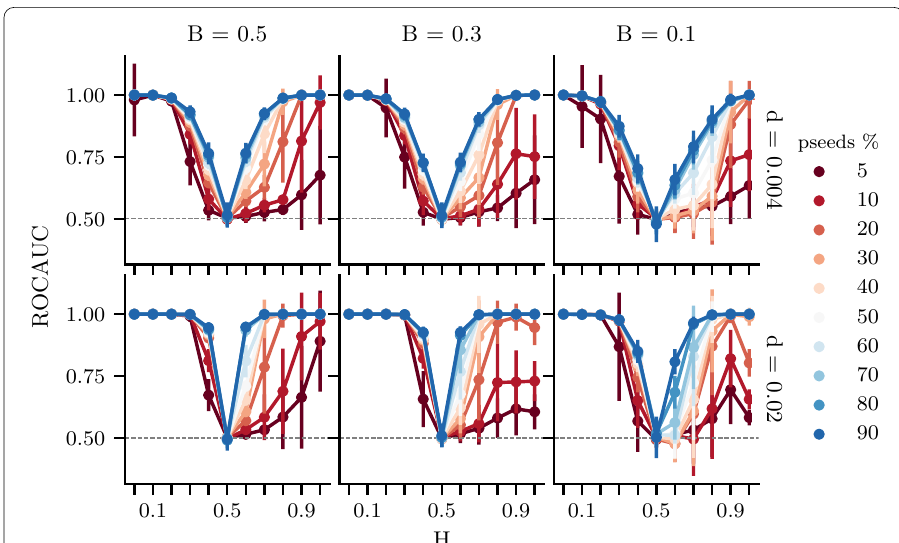
Fig. 2 RQ1: Network structure, sample size and overall performance using random node sampling and network‑only Bayes classifier (nBC). Classification performance, measured by ROCAUC scores, is shown on the y‑axis for networks with N = 2000 nodes and different levels of homophily (x‑axis), edge density (rows), class balance (columns), and sample size (colors). Dots represent mean ROCAUC scores over 50 runs, and error bars their respective standard deviation. In general we see that: (i) neutral networks H = 0.5 cannot be classified better than a random classifier; (ii) heterophilic networks H < 0.5 require smaller samples to achieve high and stable classification performance compared to homophilic networks H > 0.5 ; (iii) Dense networks d = 0.02 achieve higher ROCAUC compared to sparse networks d =